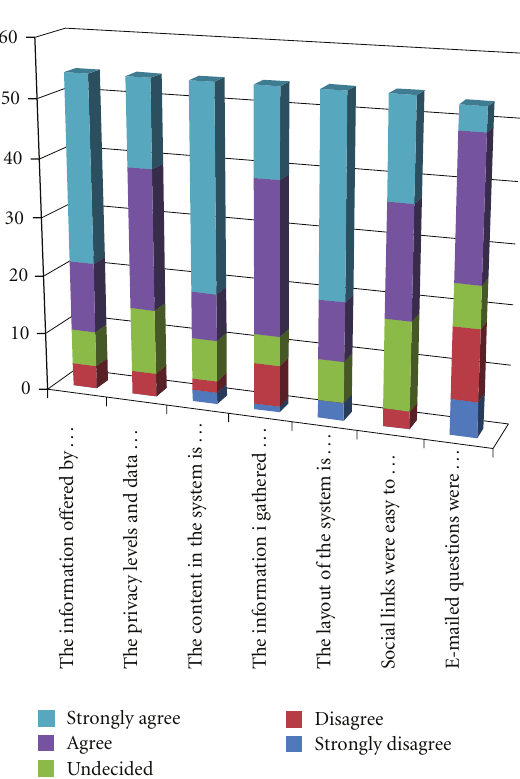
Figure 5: User evaluations, based on Table